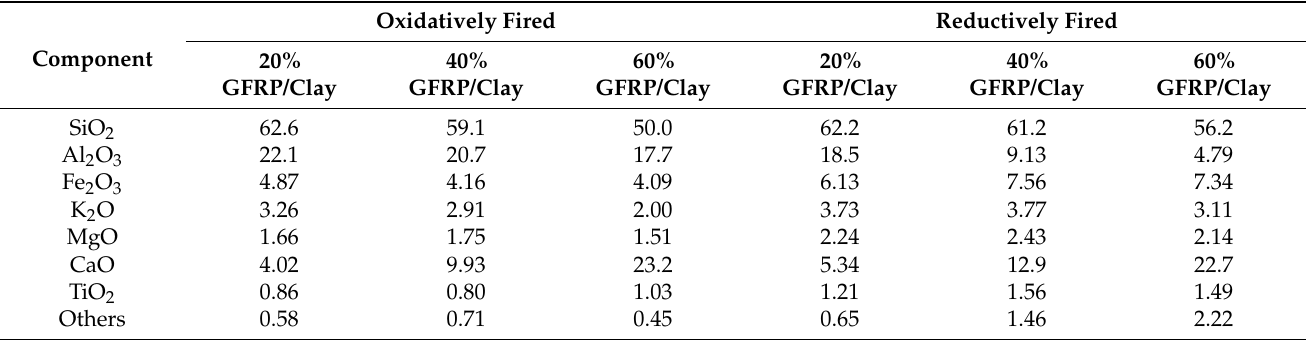
Table 3. Inorganic chemical compositions of the ceramic samples.